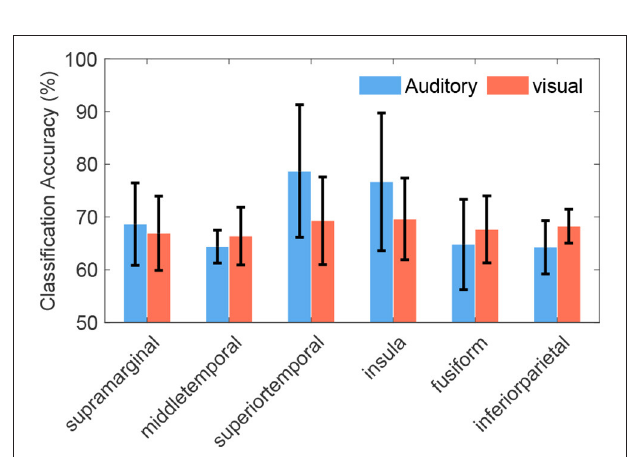
FIGURE 7 | Average classification accuracies of cross-modal regions across subjects. These regions were common in at least 67% of subjects, even the supramarginal gyrus was common in all subjects. Error bars depict the standard deviation of the classification accuracies across